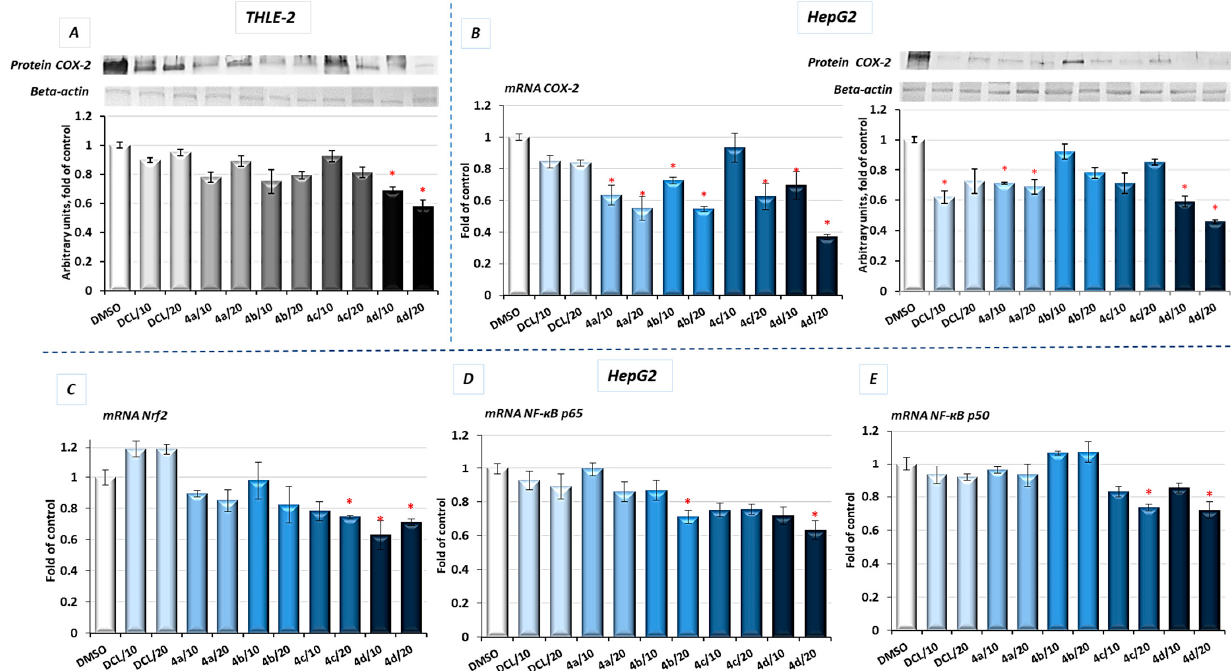
Figure 7. The effect of the DCL and DCL–OAO derivative conjugates ( 4a – 4d in 10 and 20 µ M concentrations) on the COX-2 protein level ( A ) in THLE-2 cells, COX-2 mRNA and protein levels in HepG2 ( B ) and the Nrf2 ( C ) and NF- κ B subunits’ ( D , E ) transcript levels in HepG2 cells (after 24 h incubation). The values (mean ± SEM) for the mRNA levels in HepG2 cells ( B – E ) were calculated from three separate experiments in comparison to control cells set to 100%. Representative immunoblots of the cytosolic content of COX-2 in THLE-2 ( A ) and HepG2 cells ( B ) from three separate experiments are shown. The sequence of the bands corresponds to the sequence of the bars in the graph. β -actin was used as a loading control. The values were calculated as protein levels in comparison to control cells set to 100%. * Significantly different from control- DMSO-treated cells, p < 0.05. Statistical significance was assessed by Student’s- t